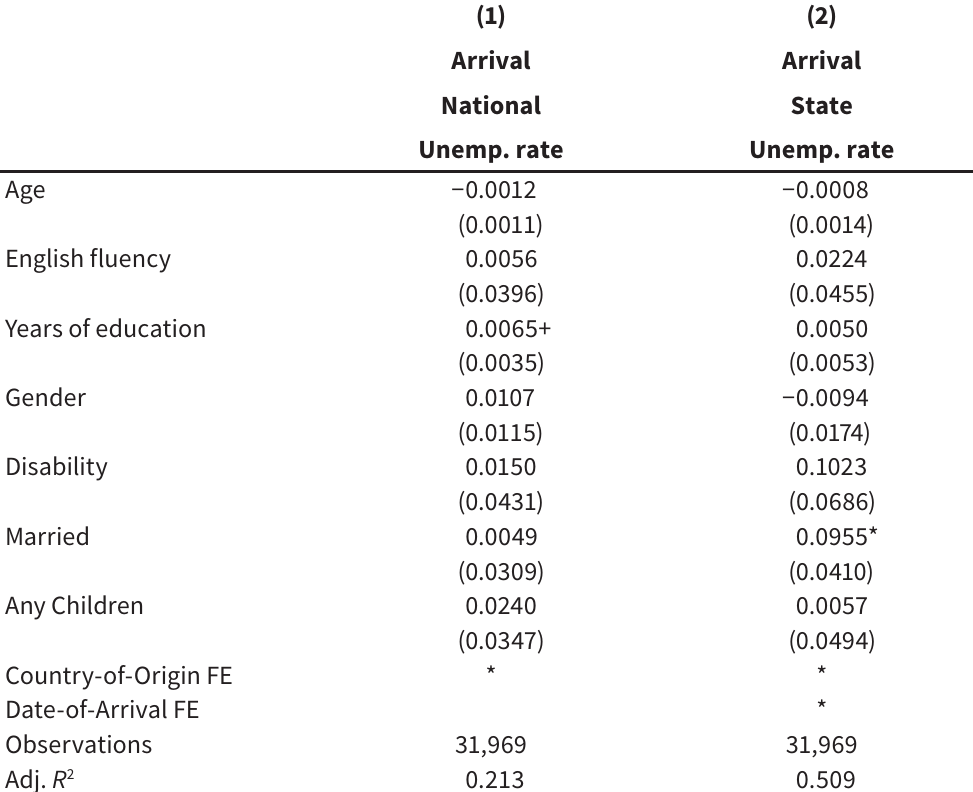
Test of balance for continuous treatments